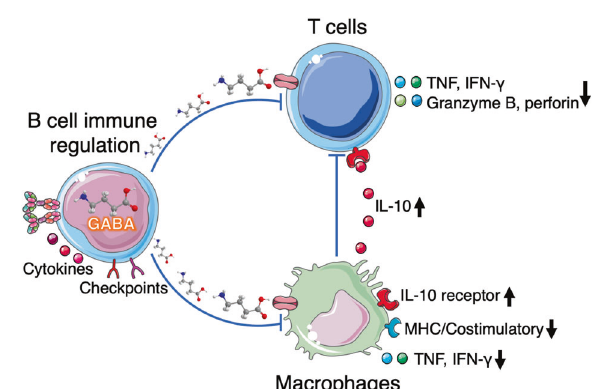
beta (TGF- β )) and surface expression of checkpoint proteins (e.g., PD-1/L1). The current study 1 demonstrated that activated B cells can also produce the neurotransmitter GABA to impair the anti-tumor capability of T cells and macrophages. GABA directly inhibited T cell activation by downregulating in fl ammatory cytokines (e.g., TNF and IFN- γ ) and cytotoxic proteins (e.g., granzyme B and perforin). Moreover, GABA induced anti-in fl ammatory tumor-associated macrophages which released IL-10 and this suppressed T cell activation. The fi gure elements are available from